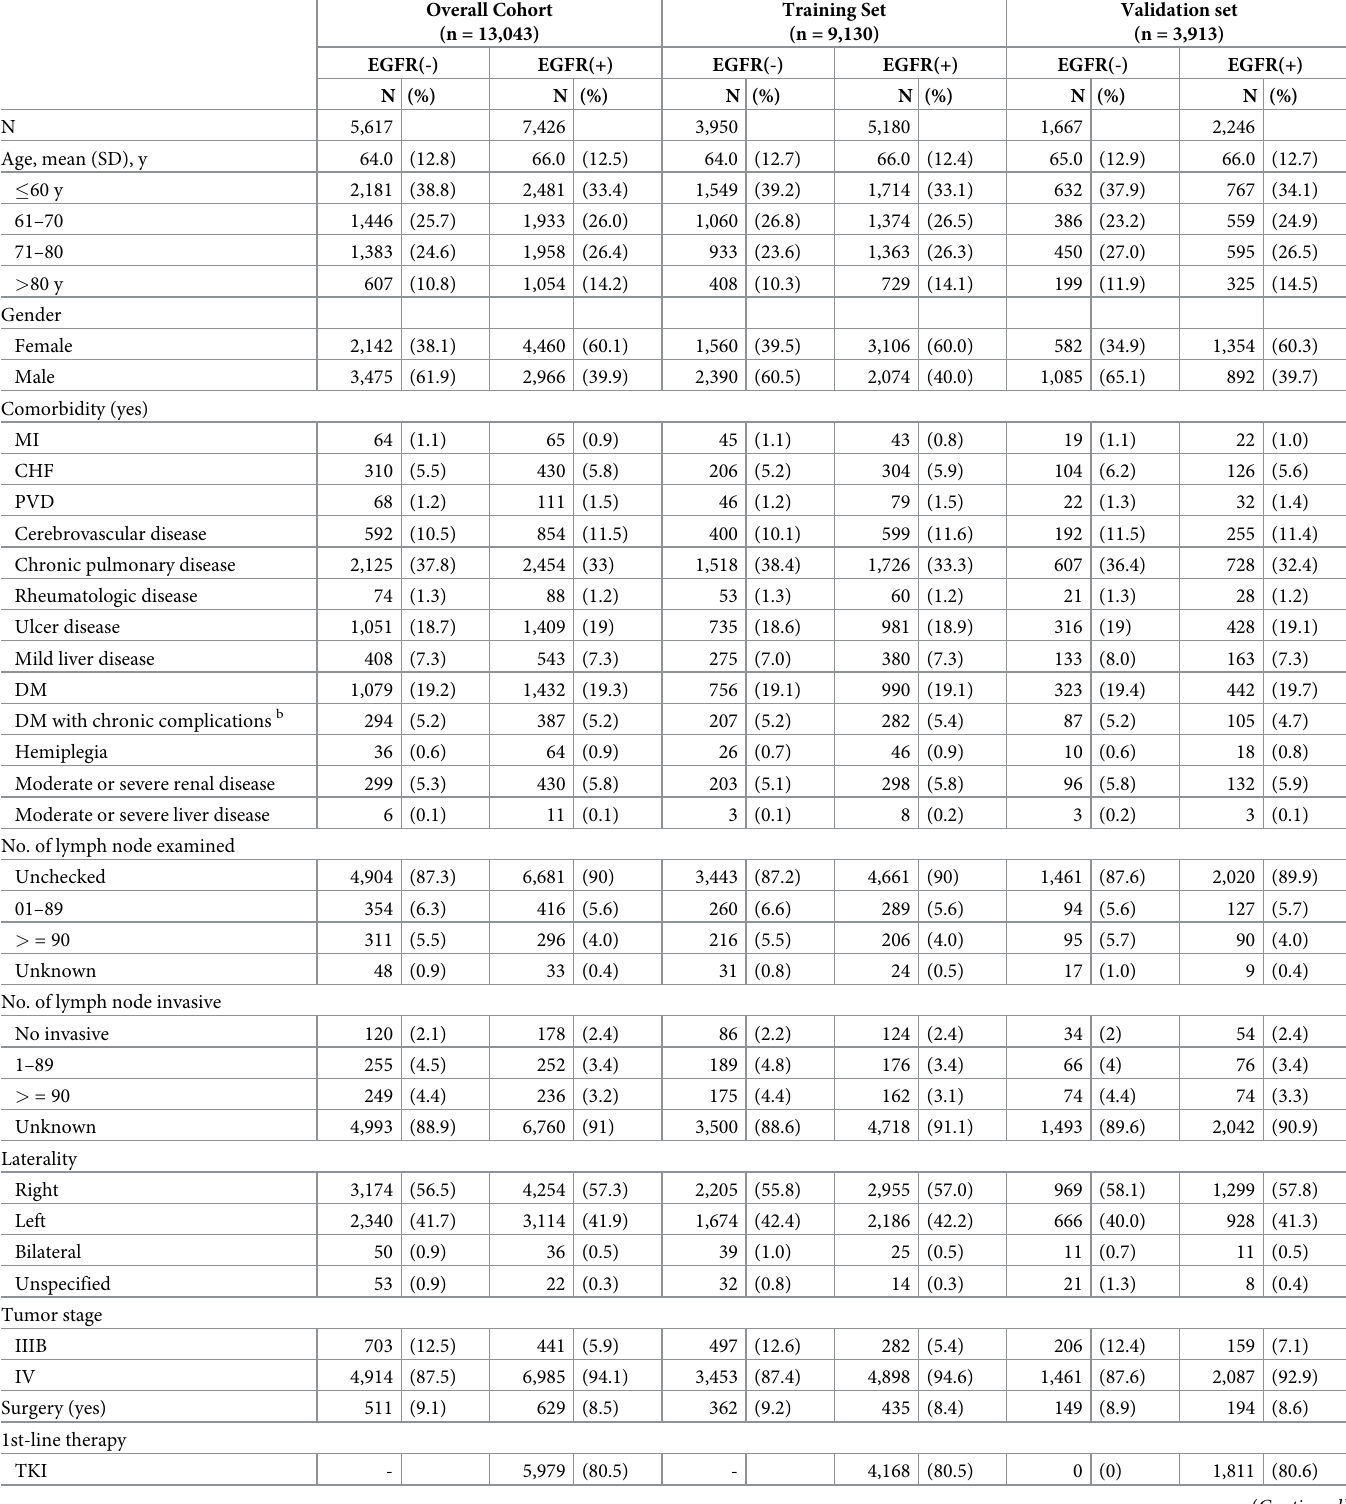
Table 1. Demographics and clinic pathologic characteristics of patients with advanced stage